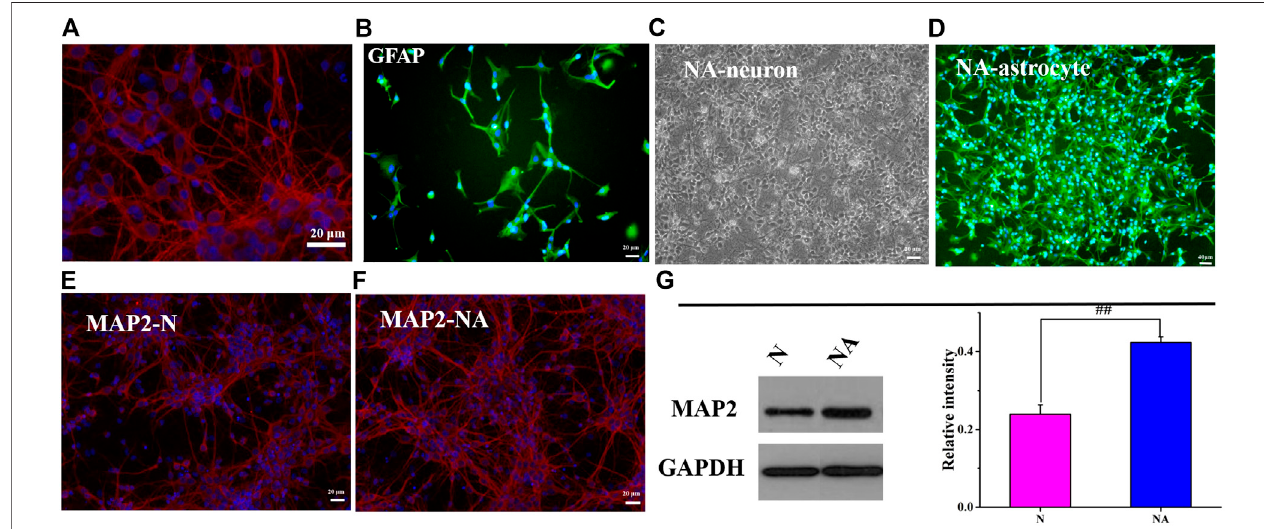
FIGURE2| NeuronalmorphologyintheNgroupandNAsystem. (A) NeuronswerepositiveforMAP-2(red). (B) AstrocyteswerepositiveforGFAP(green). (C) The morphology of neurons in the coculture system. (D) The morphology of astrocytes in the coculture system. (E) MAP-2 (red) in the N group (N). (F) MAP-2 (red) in the NA group (NA). (G) The expression of MAP2 in the N group and NA group. ## p < 0.01, N vs. the NA group.